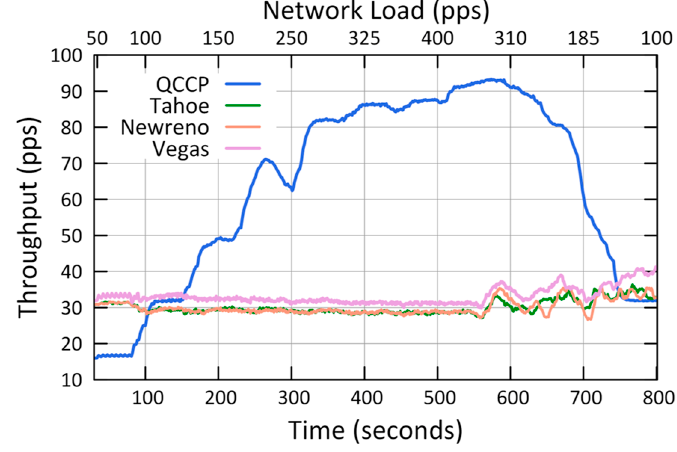
Figure 12. Comparison of average throughput in the network (T H ).